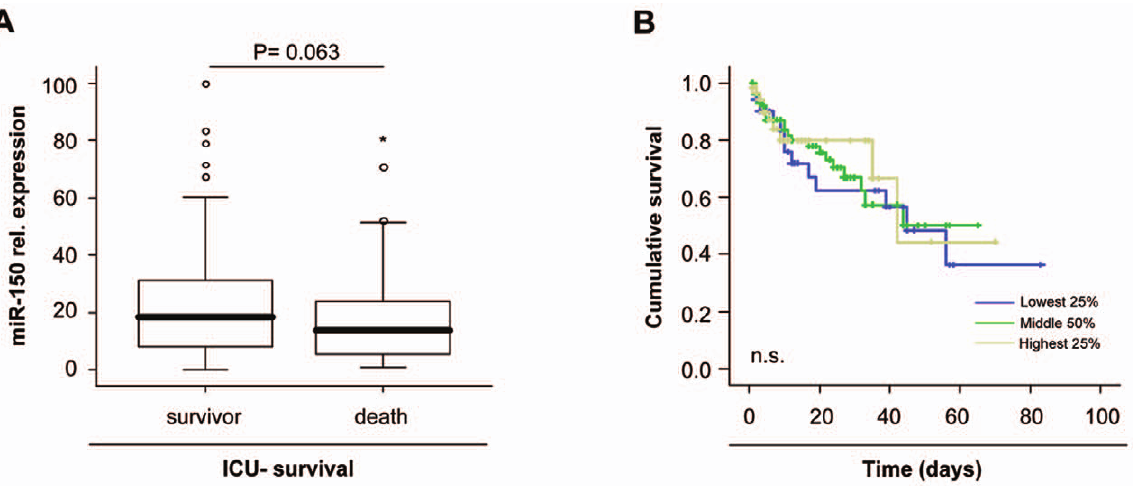
Figure 4. Prediction of ICU mortality by miR-150 serum concentrations. (A) Patients that die during the course of ICU treatment had a tendency towards lower miR-150 serum levels on admittance to ICU than survivors (P=0.063, U-test). Box plot are displayed, where the bold line indicates the median per group, the box represents 50% of the values, and horizontal lines show minimum and maximum values of the calculated non-outlier values. (B) Kaplan-Meier survival curves of ICU patients are displayed, showing that patients with miR-150 levels within the lowest quartile of all patients displayed the lowest short-term survival at the ICU. Significances are given in the figure.